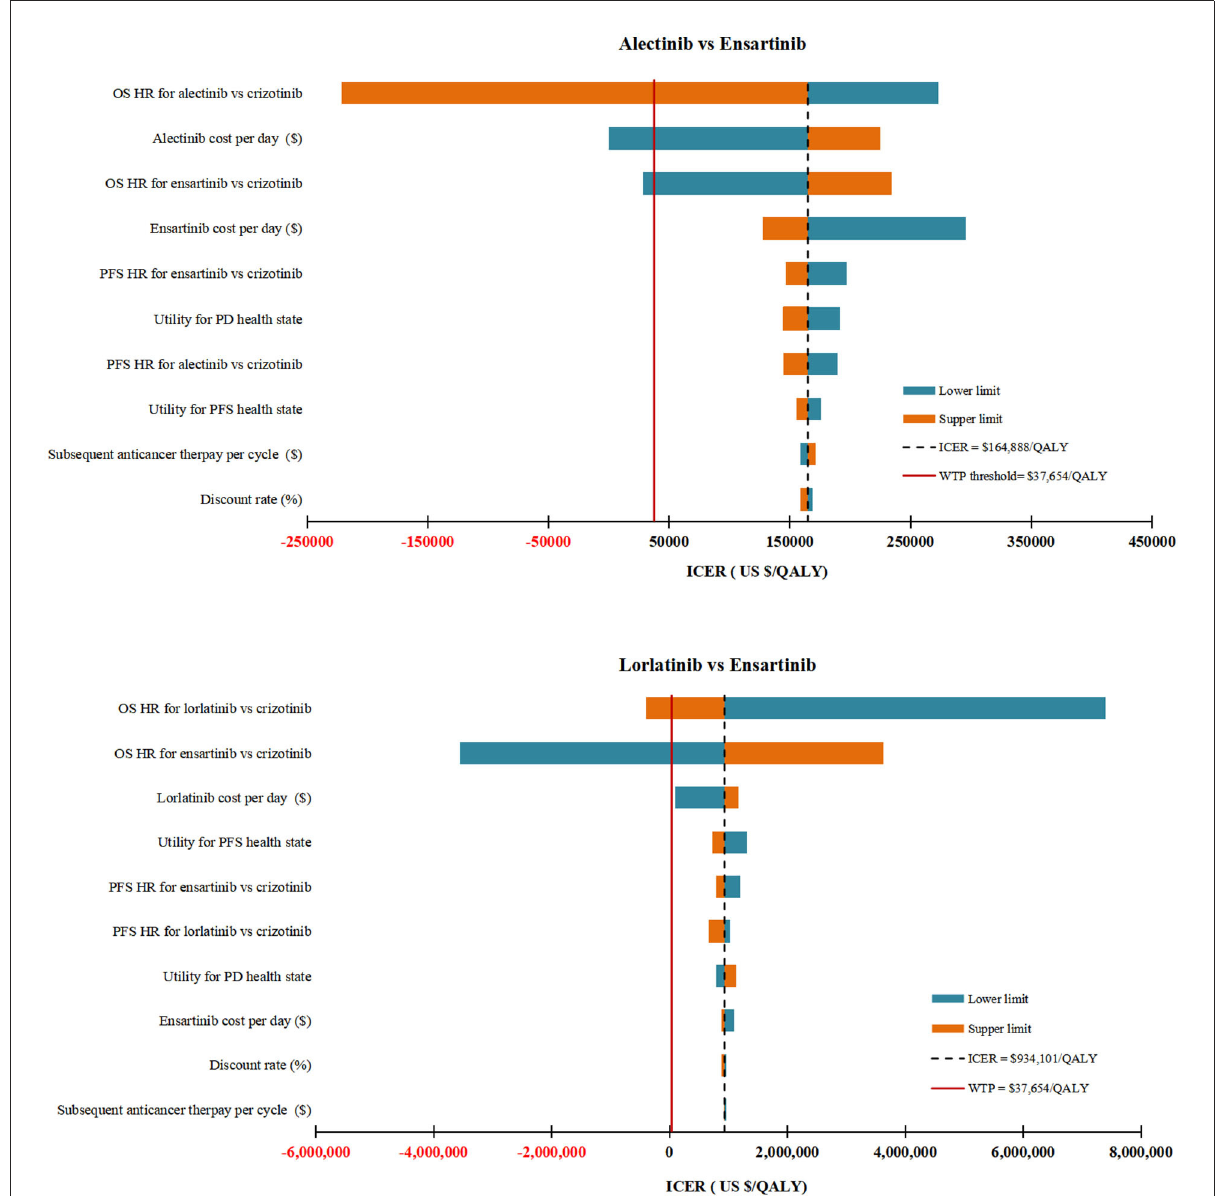
FIGURE2 Deterministic sensitivity analysis results. The top 10 parameters by magnitude of effect on the ICER were presented. ICER, incremental cost-effectiveness ratios; QALY, quality-adjusted life-years; WTP, willingness-to-pay; OS, overall survival; PFS, progression-free survival; PD, progressive disease; HR, hazard ratios; BSC, best supportive